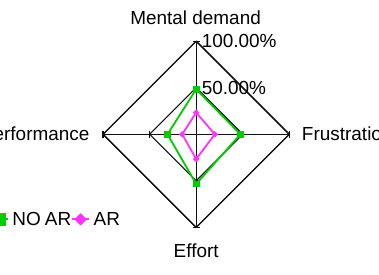
Figure 19. NASA-TLX questionnaire results. The AR line indicates average results of the VHAR interface; the NO AR line indicates average results without visual-feedback.